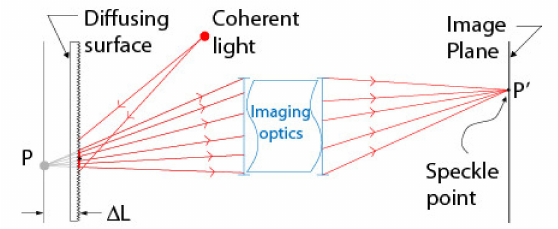
Figure 12. Basic principle of defocused subjective speckle. A diffusing surface is illuminated by a coherent light source. A spot on the surface (corresponding to in-focus point P ) is imaged on the image plane as point P (cid:48) by the optics of the camera. Speckle point P (cid:48) results from the combination of waves coming from the spot on the diffusing surface. In focus subjective speckle is obtained when D L = 0. In this case, speckle point P (cid:48) results from the combination of waves coming from the single point P on the diffusing